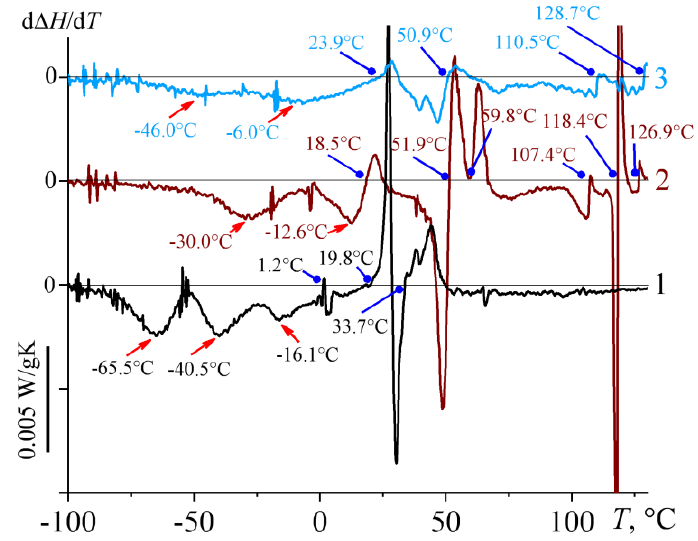
Figure 5. Temperature dependences of differential heat flow for bitumens 1 – 3 as typical examples. The red triangular-ending arrows indicate local minima corresponding to glass transition temperatures, while the blue round-ending arrows mark points at which the rising curves take on zero values, specifying melting temperatures.